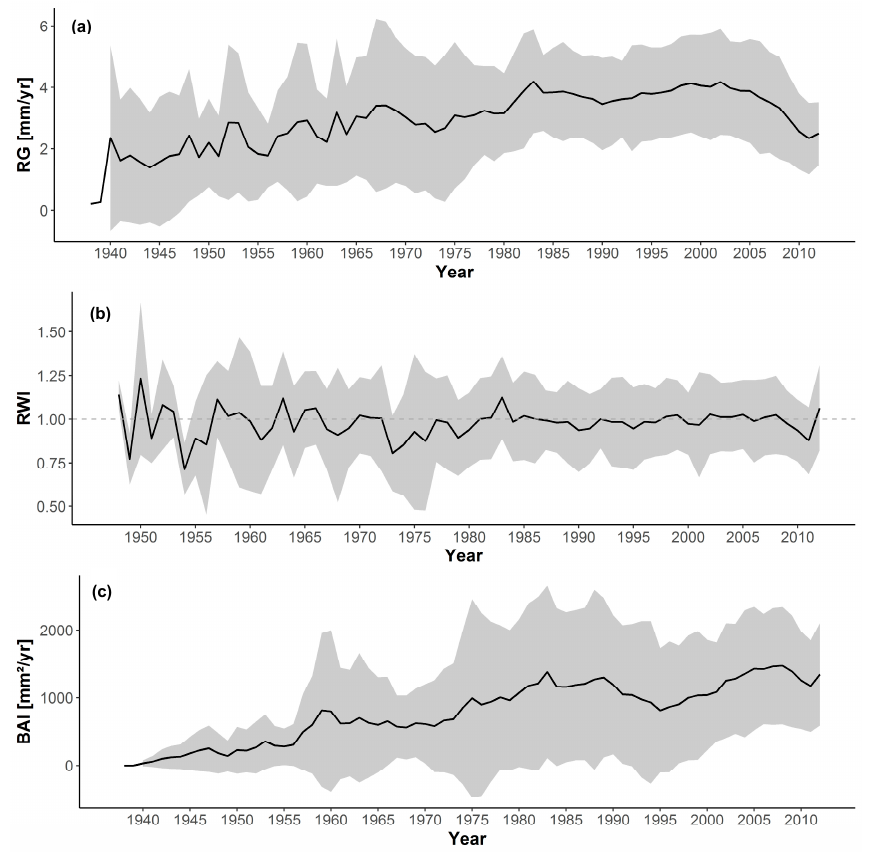
Figure 4. Radius growth, RG ( a ), indexed growth values, ring-width indices (RWI) ( b ), and basal area increments, BAI ( c ), of all sampled A. sachalinensis trees in Sapporo.